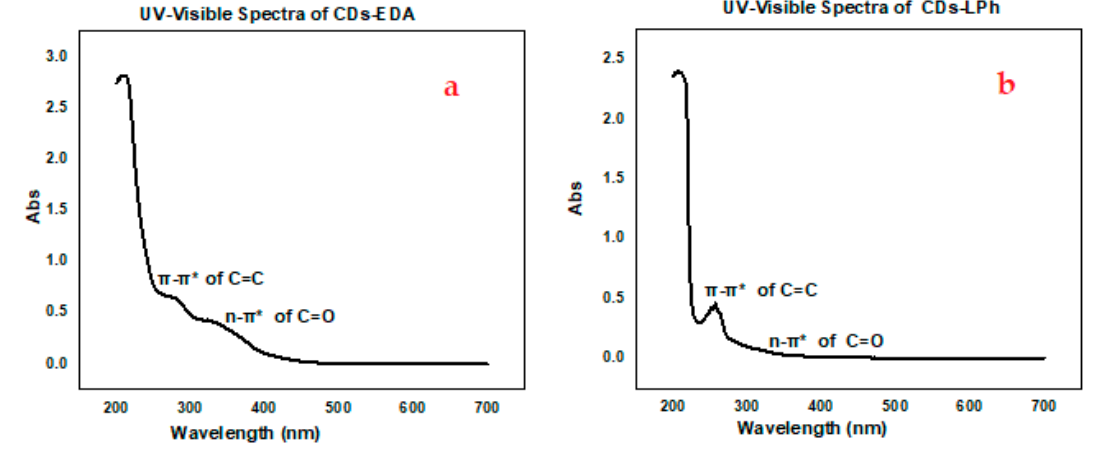
Figure 8. UV-Visible spectra of ( a ) CDs-EDA and ( b ) CDs-LPh.